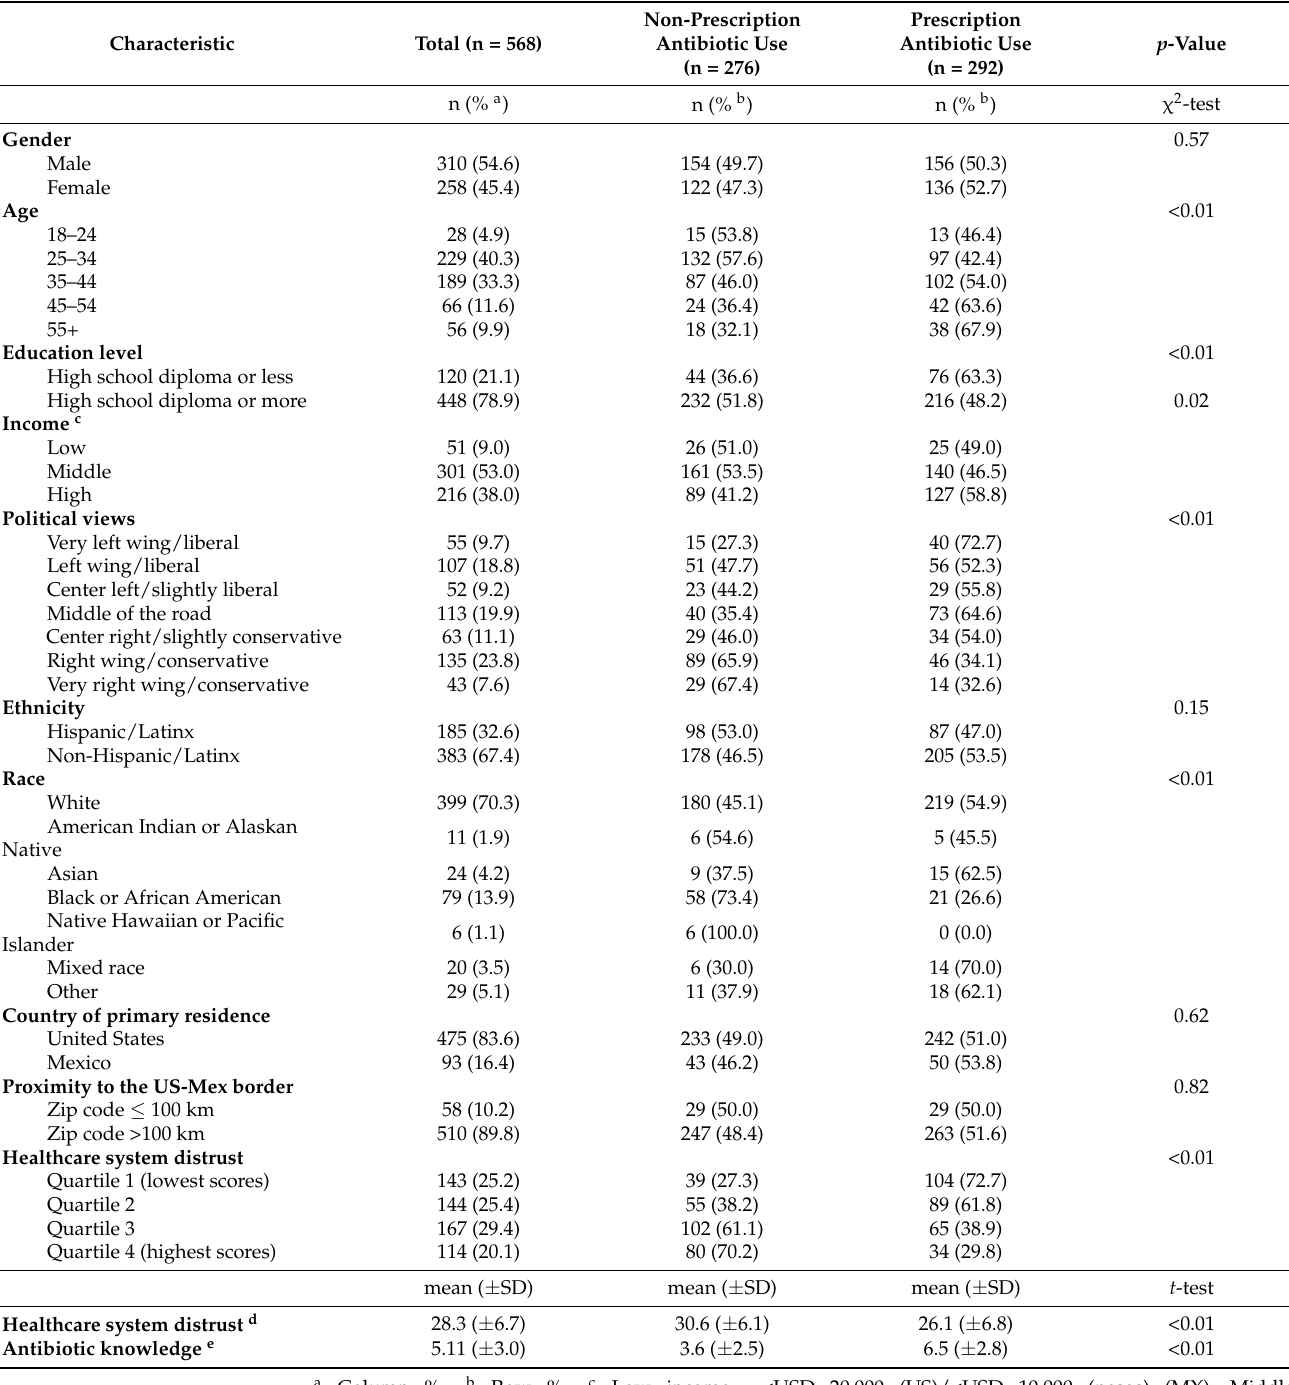
Table 1. Results of logistic regression analysis for non-prescription antibiotic use with healthcare system distrust as a predictor (n =